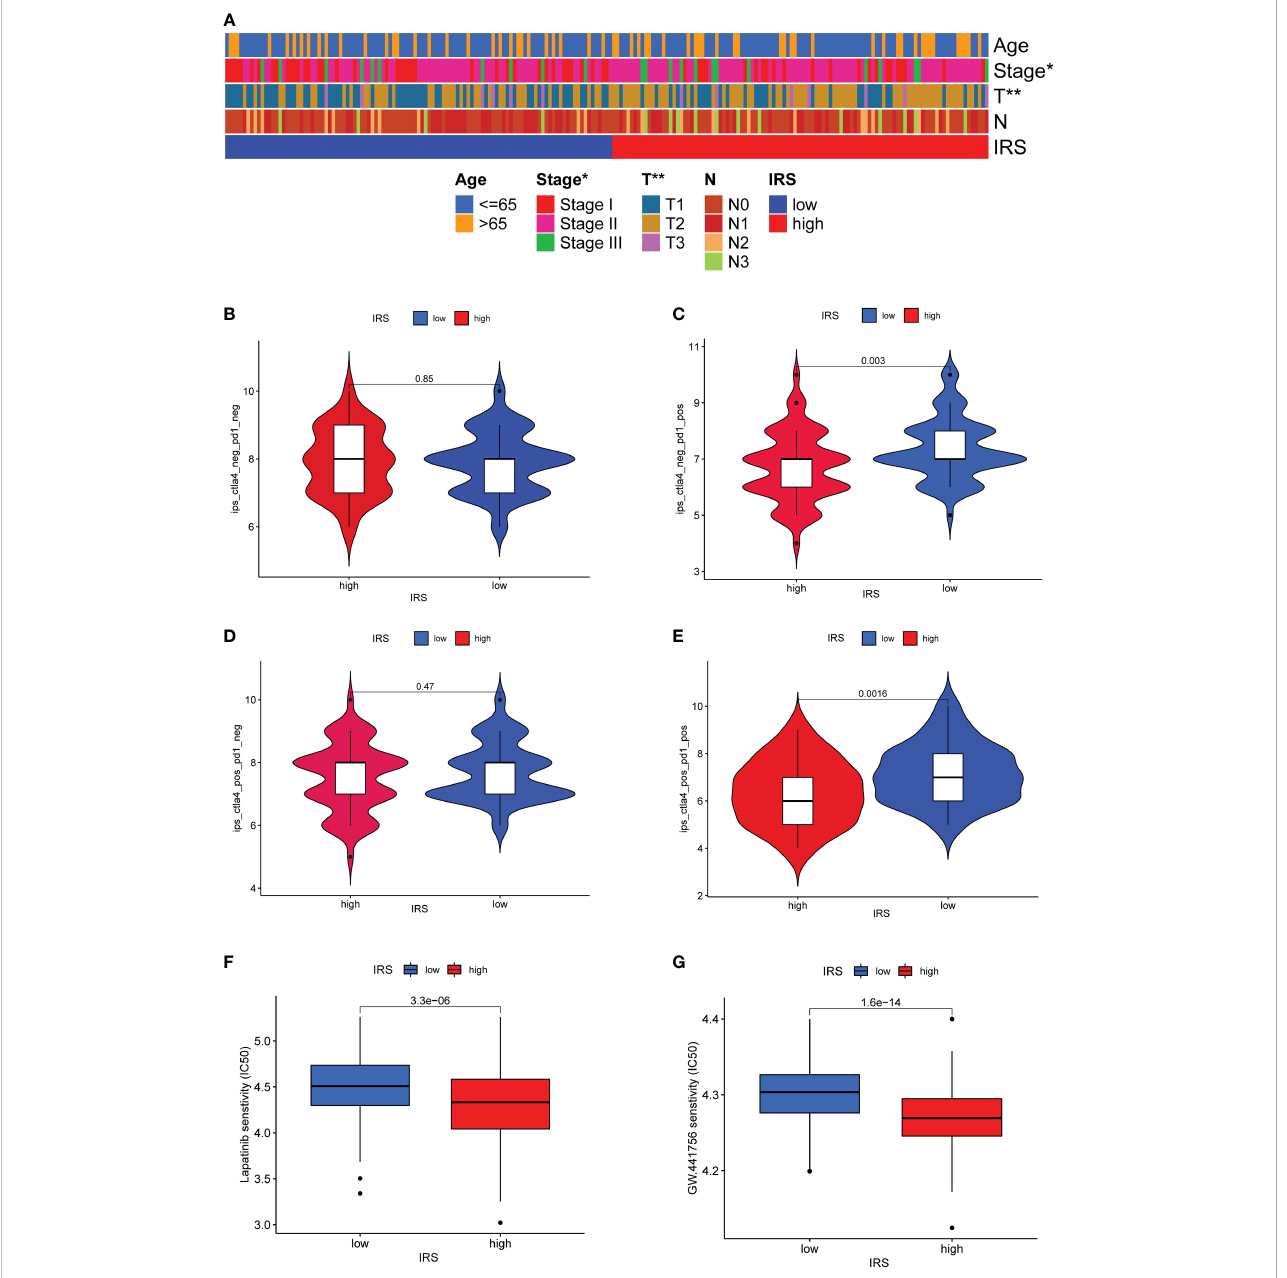
FIGURE 7 Predictive value of ICGs-related riskscore model in ICIs therapy. (A) Heatmap showing the relationship between IRS and clinicopathological parameter. (B – E) The relative distribution of IPS identi fi ed by the status of CTLA-4 or PD-1 was compared between high IRS group versus low IRS group in TCGA- TNBC cohort. (F, G) Drug sensitivity analysis in different IRS